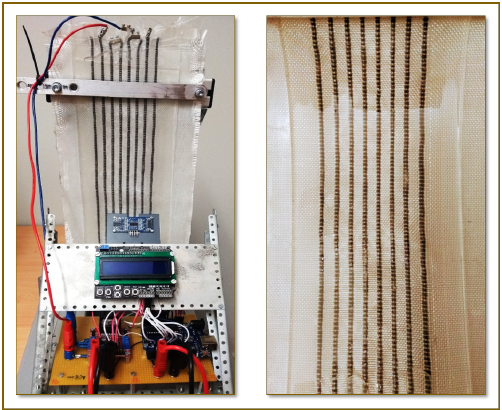
Figure 1. Test bench of textile-reinforced composite specimen with integrated shape memory alloys